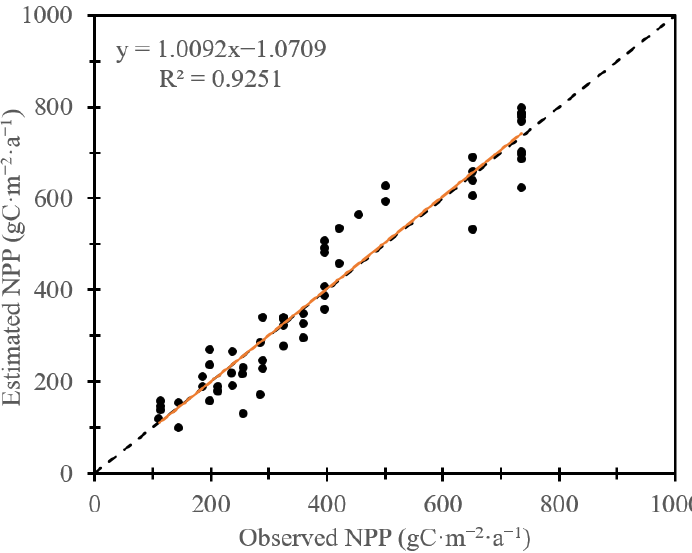
Figure 2. Observation vs. simulation based on the CASA model over our study area in 2010. R 2 = 0.92; NRMSE = 0.15.